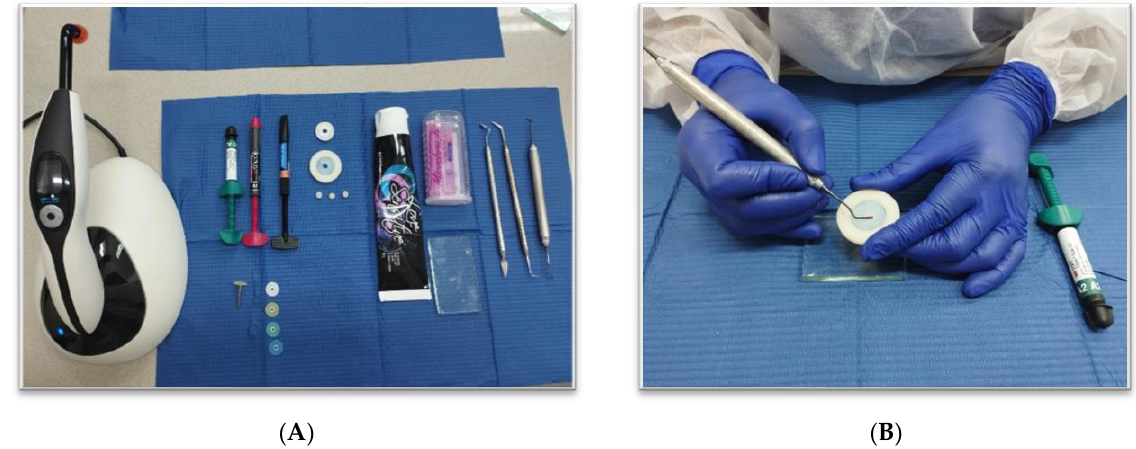
Figure 2. ( A ) Materials and instruments used; ( B ) resin composite compaction inside the block.